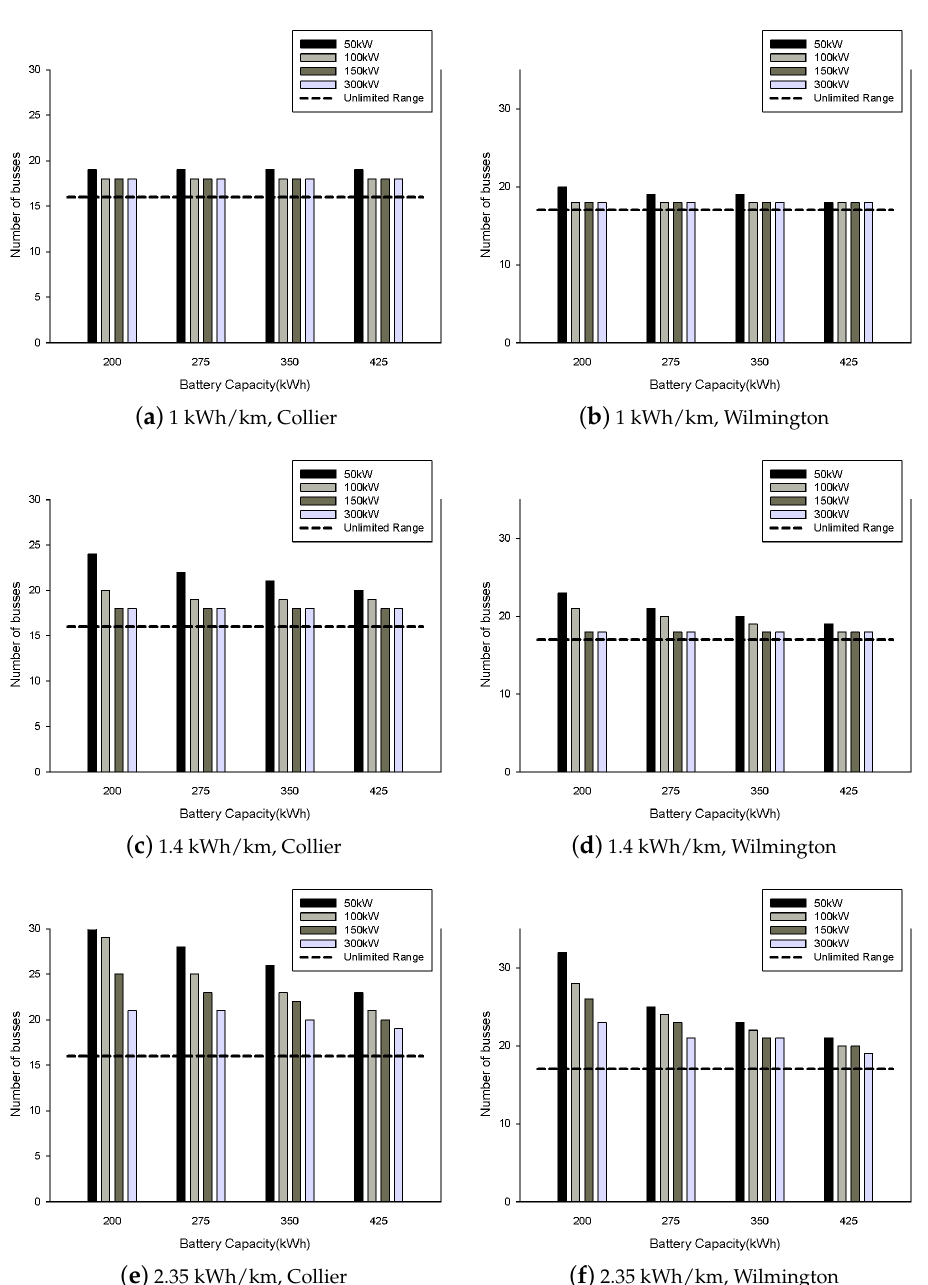
Figure 6. Number of EBs with different ranges dependent on depot charging power to achieve a medium public bus transport system. In each of the subfigures the dashed line corresponds to the number of DBs needed for the same